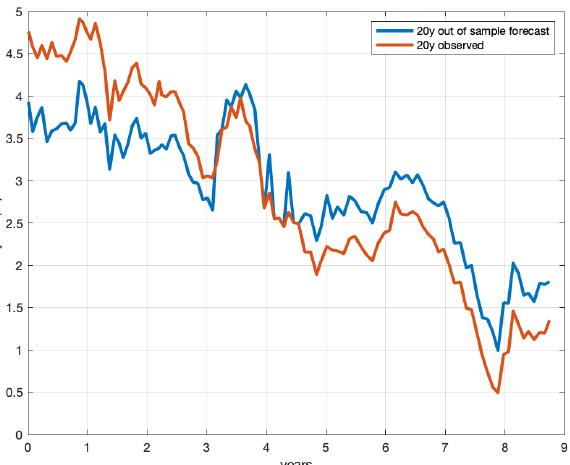
Figure 7. Comparison between the market yield rate (blue line) and the model − implied yield rate (red line) for the 20 − year